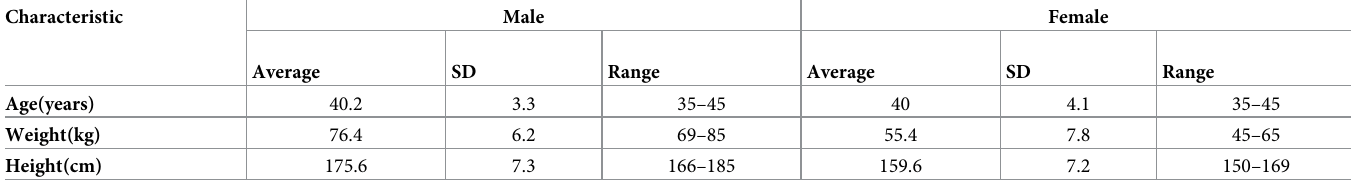
Table 1. Characteristics of subjects.